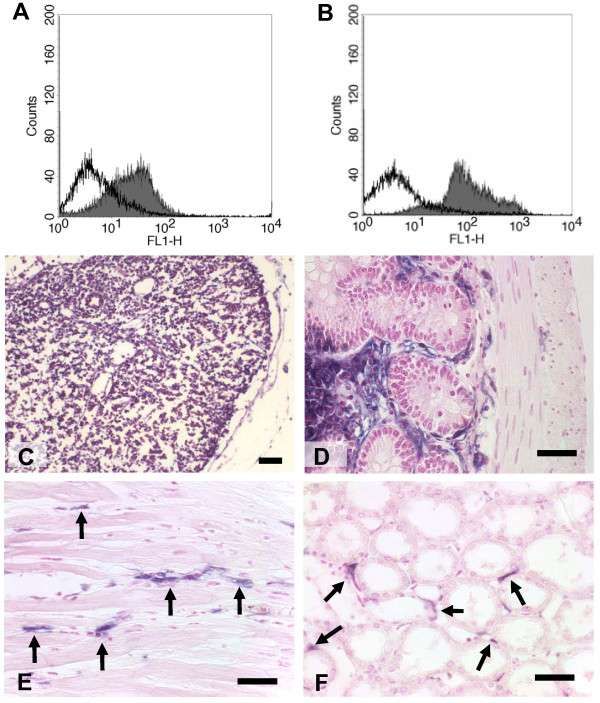
Expression of hPLAP in tissues of irradiated wild-type rats transplanted with bone marrow from hPLAP-tg rats [WT (hPLAP-BMT)], 4 weeks post-transplantation. FACS analysis reveals hPLAP expression (mAb clone 8B6) on peripheral blood leukocytes (A) and bone marrow cells (B) in irradiated WT (hPLAP-BMT) rats (grey area) in contrast to wild-type rats (white area). All leukocytes in lymph nodes demonstrate clear hPLAP staining (C). In cross-sections of the ileum, enterocytes and smooth muscle cells remain unstained, while cells in the submucosa and endothelial cells show intense hPLAP labeling (D). Cardiomyocytes (E) and renal tubular epithelial cells (F) are hPLAP negative cells of recipient origin, while a significant portion of capillary endothelium in heart and kidney is of donor origin as indicated by hPLAP labeling (arrows). Five-μm-thick paraffin sections of abdominal lymph node (C), ileum (D), heart (E), and kidney (F) stained for hPLAP activity and counterstained with nuclear fast red. Bar = 50 μm.